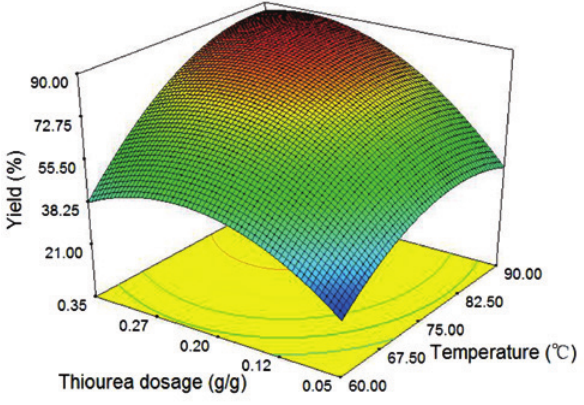
Figure 5: Three-dimensional response surface and contour plot of thiourea dosage vs. leaching temperature on CeO